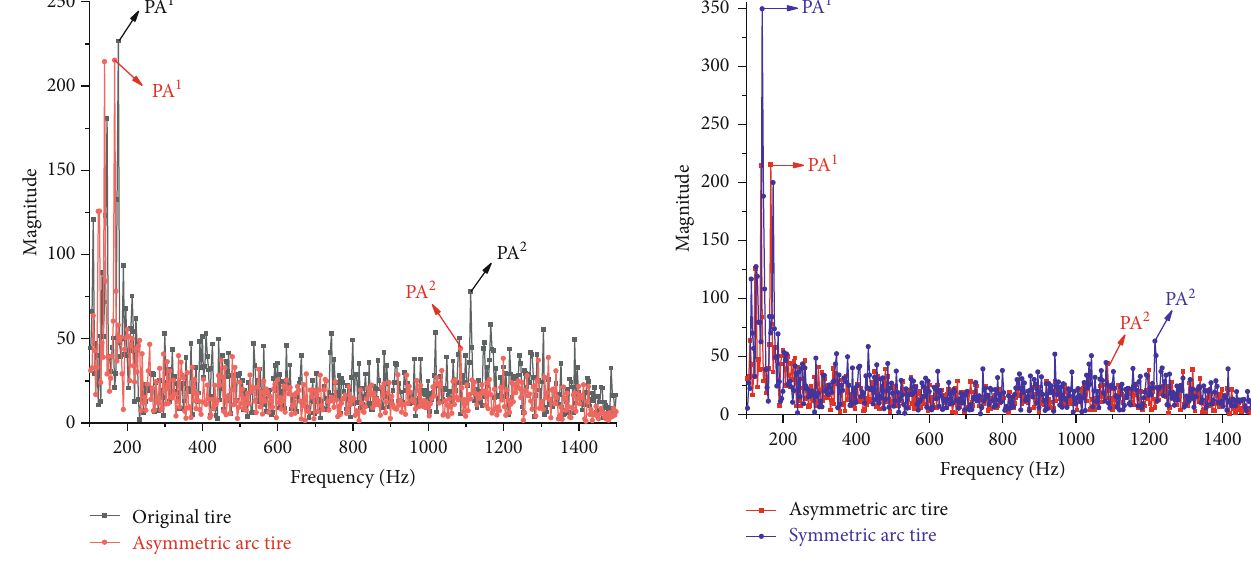
Figure 15: The spectrum comparison between the asymmetrical arc tire and the original tire.